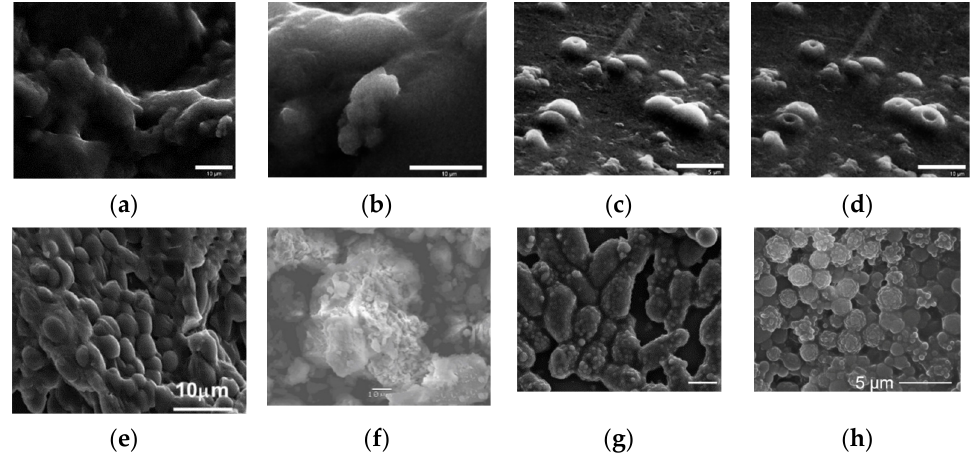
Figure 7. Micrographics of immobilized yeast cells in various sol-gel matrices. ( a ) SEM images of PGS-derived silica gels containing S. cerevisiae cells. ( b ) Typical long-range morphology with some shallowly encapsulated cells visible. Image ( d ) was collected several minutes after image ( c ), showing the development of depressions during imaging [34]. FE-SEM images of baker’s yeast encapsulated in sol–gel silica: ( e ) [63]. ( f ) Freshly harvested Lodderomyceselongisporus cells immobilized in a second generation (supported with hollow-silica microspheres) sol-gel system [67]. ( g ) Cryptococcus curvatus encapsulation in silica sol-gel. SEM micrographs showing the formation of 3D sol-gel biomatrix architecture when the ratio between the silane precursors (TEOS and MTES) (vol%) was 85:15. Scale bar, 5 µm [68]. ( h ) SEM micrograph showing the formation of a 3D structure hybrid material based on Ogataea polymorpha VKM Y-2559 cells encapsulated in an organosilica hydrogel MTES:TEOS 85:15 vol. % and PVA [25]. Micrographs reprinted with permissions from the given references.